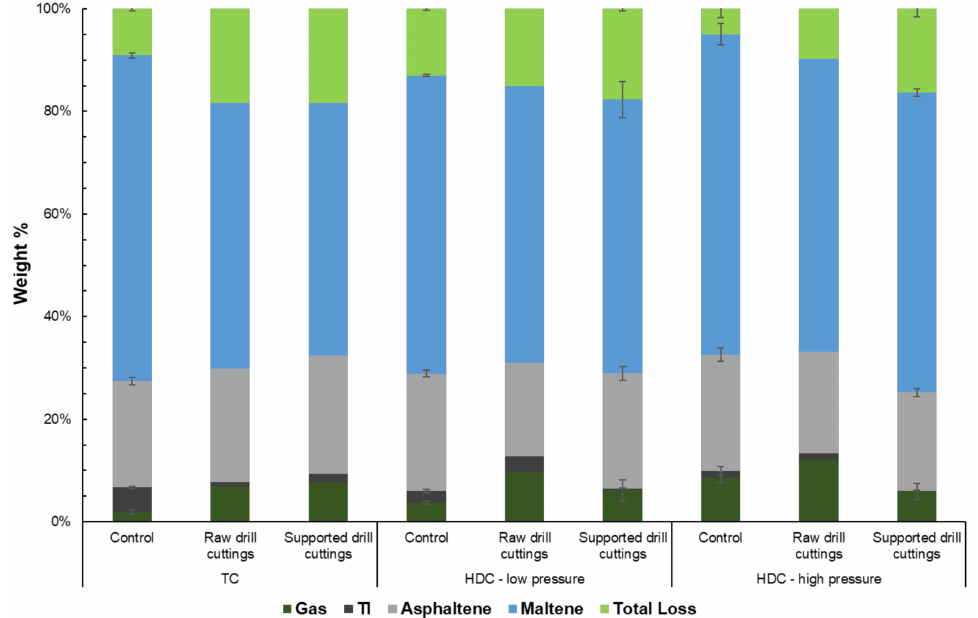
Figure 7. Final yield of various product oil fractions. Total loss is the mass lost during toluene and n-heptane evaporation in the form of volatiles. The pressure was 70 psi and 365 psi for low and high-pressure runs,